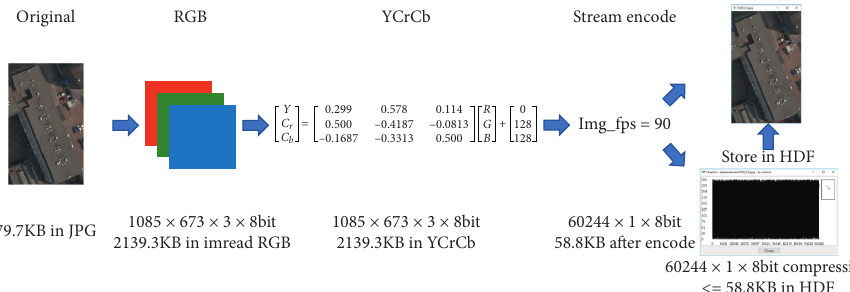
Figure 15: Flowchart of image processing with an exemplary image (image source from [35]).